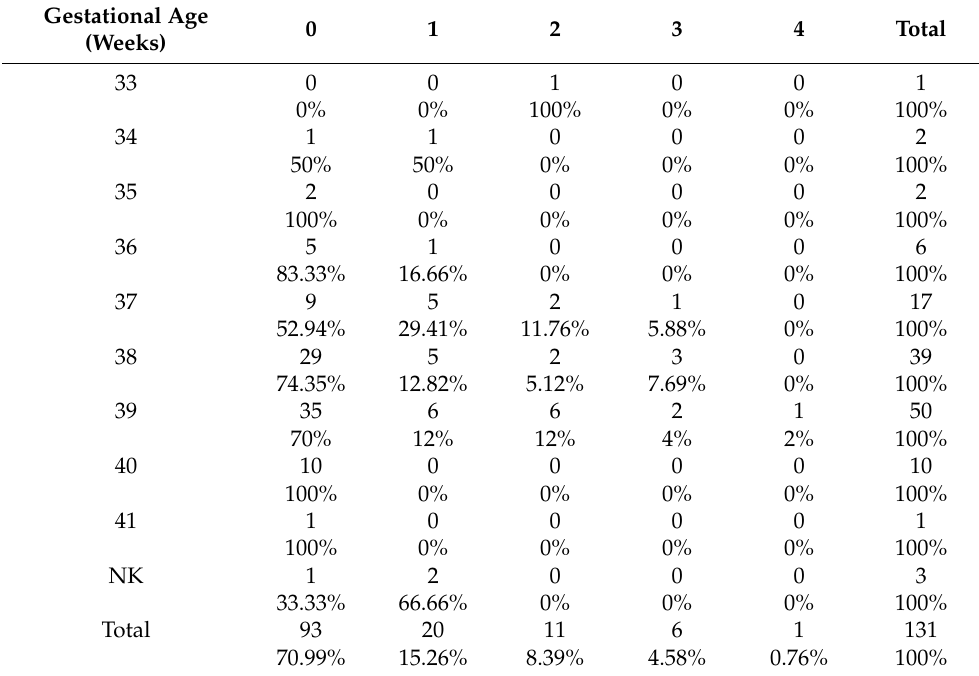
Table 22. The proportion of the patients’ PUUS values regarding the gestational age of the parturients. There were three patients whose gestational age was not known because they arrived during the fetal expulsion period, and they had not been surveyed during